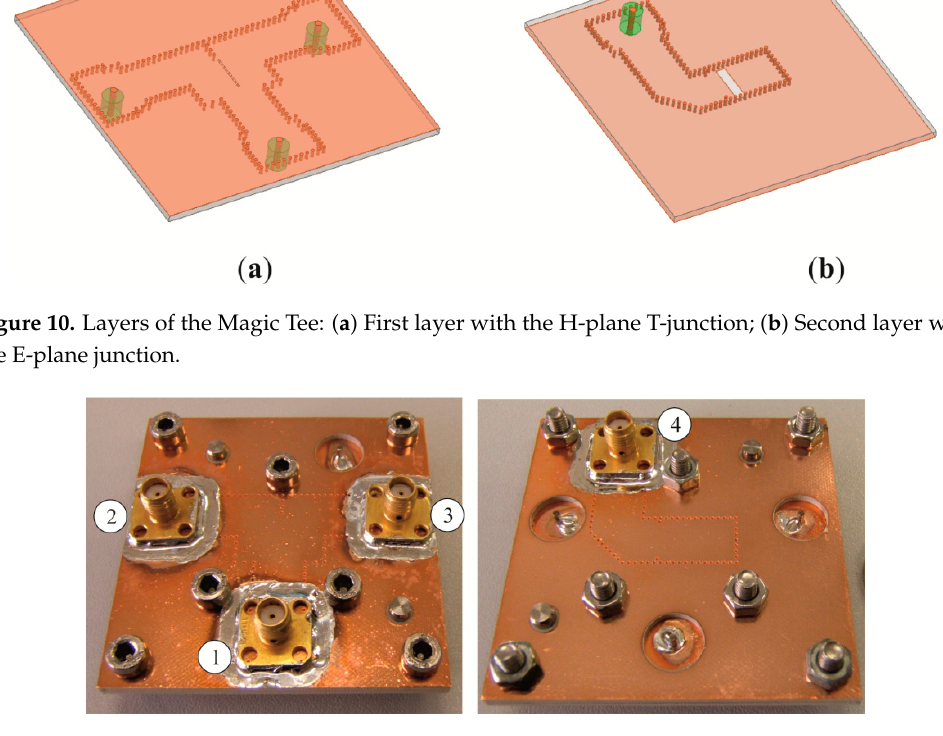
Figure 11. Assembled double-layer Magic tee.